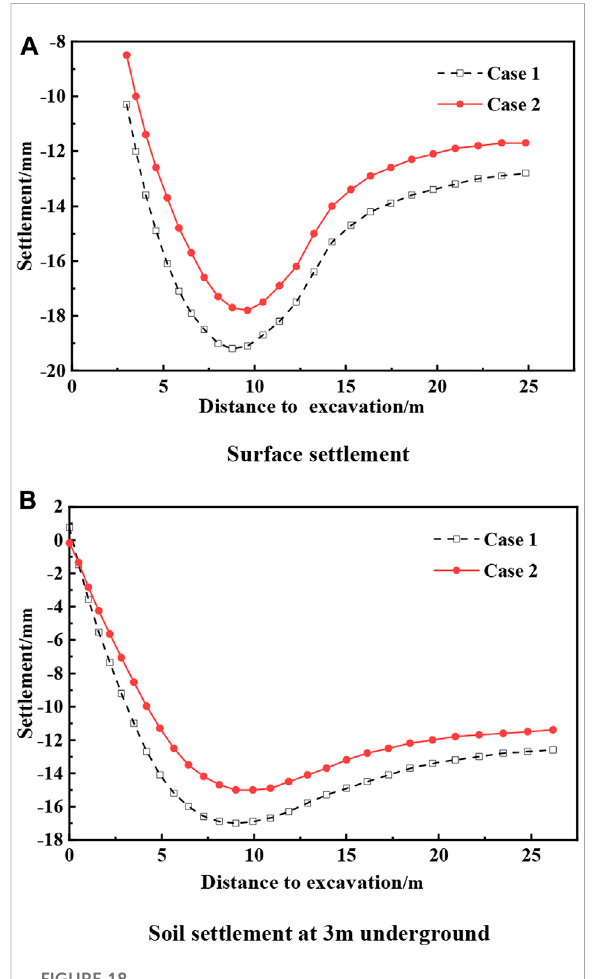
FIGURE 18 Settlement curves at the right side of Case 1 and Case 2. (A) Surface settlement. (B) Soil settlement at 3 m underground.